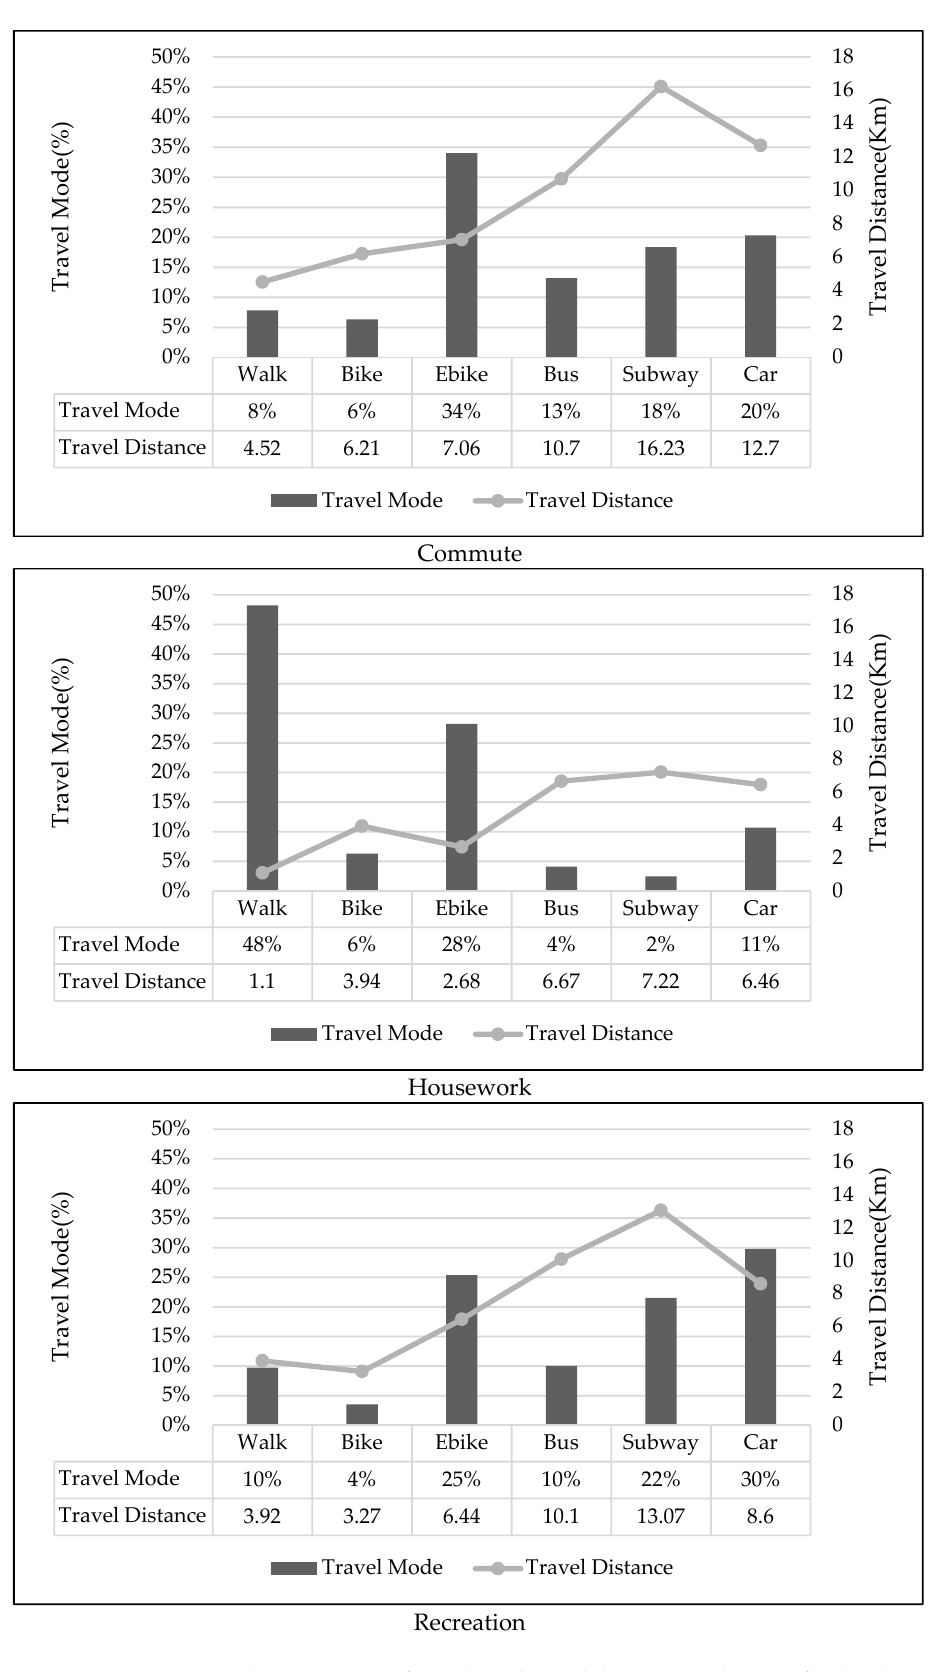
Figure 4. The proportion of travel modes and the average distance for the three travel purposes.